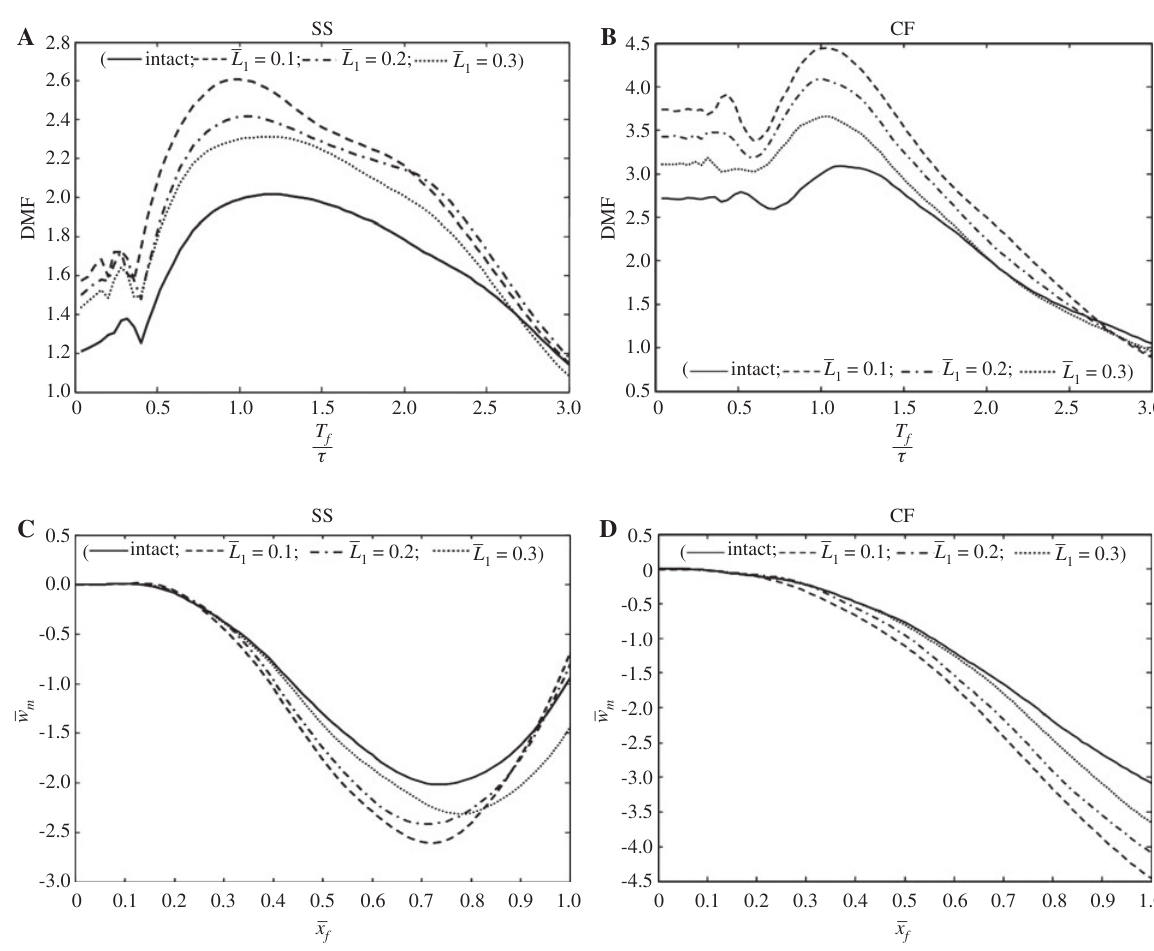
Figure 7 (A, B) Variation of DMF vs. T tion spanwise location at load critical velocity (